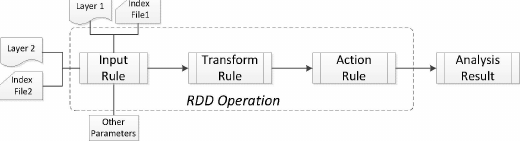
Figure 4. The process of spatial inspection analysis